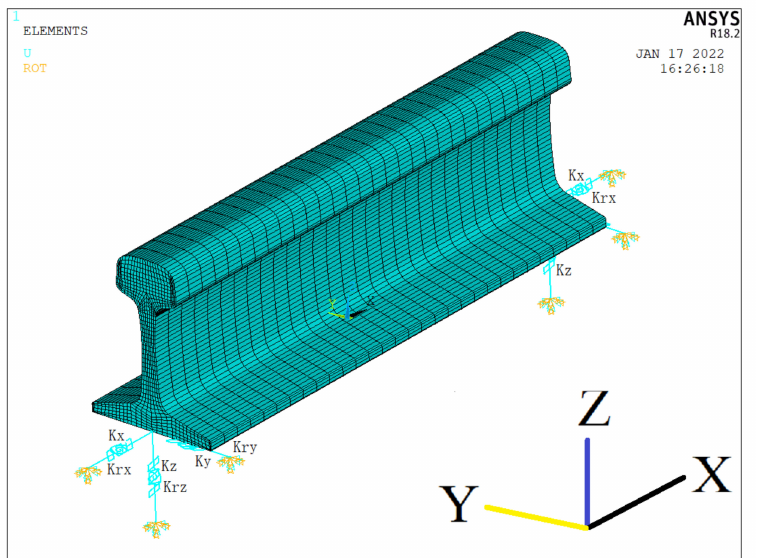
Figure 2. Schematics of the FEM unit cell implemented in this study along with the springs used to model the effects of the fasteners, crossties, and